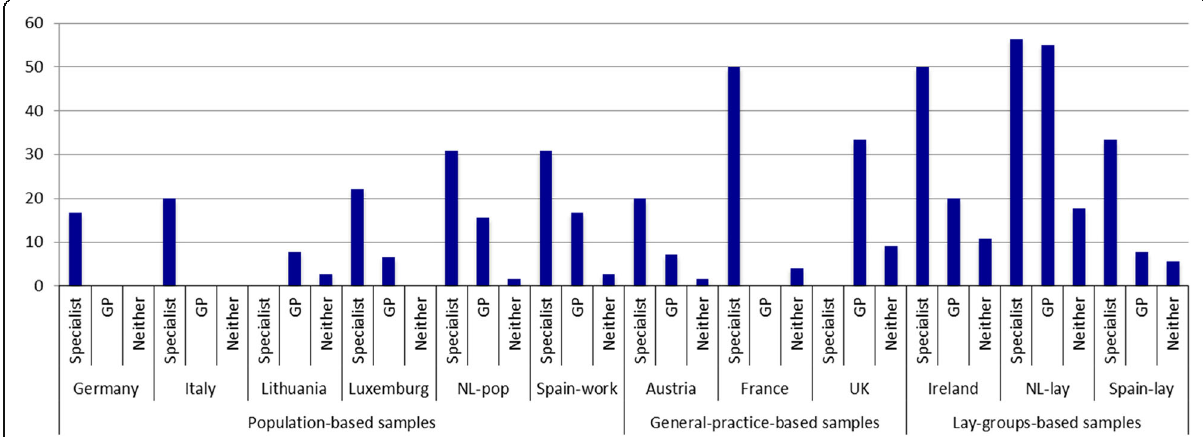
Fig. 2 Proportion (%) of eligible participants with using migraine-preventative treatment, by country and by whom consulting. NL-pop: Netherlands- population; Spain-work: Spain-workplace; NL-lay: